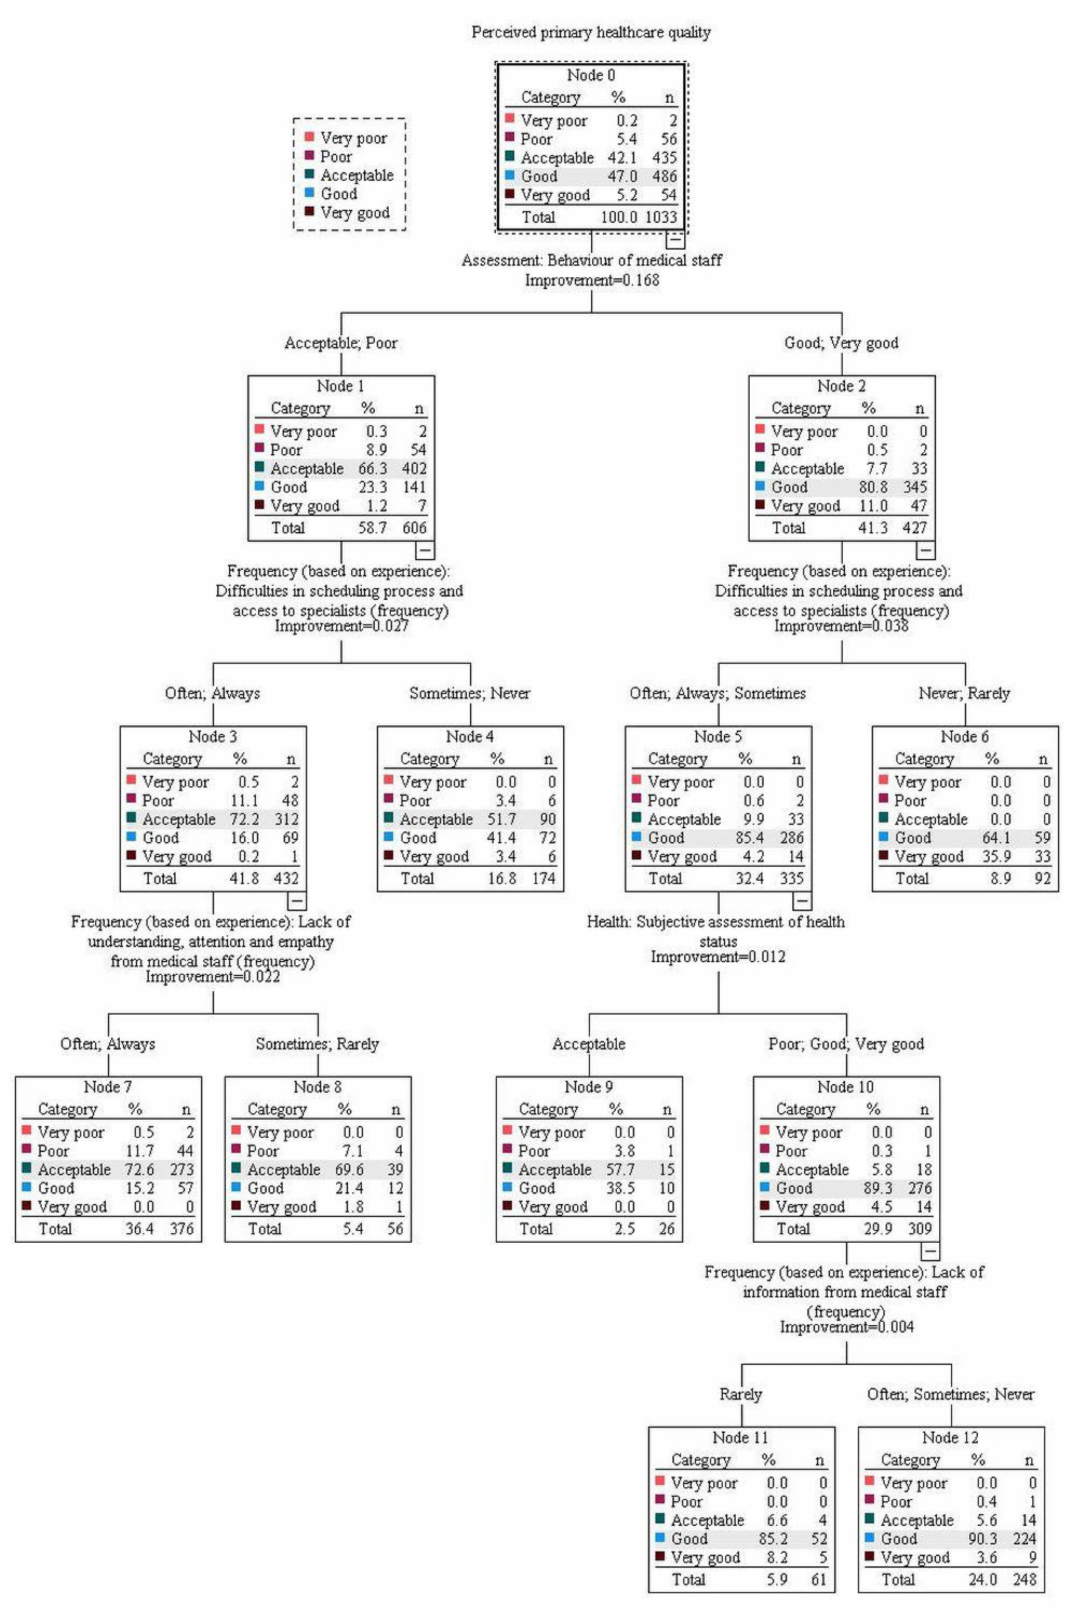
Figure A1. CRT model